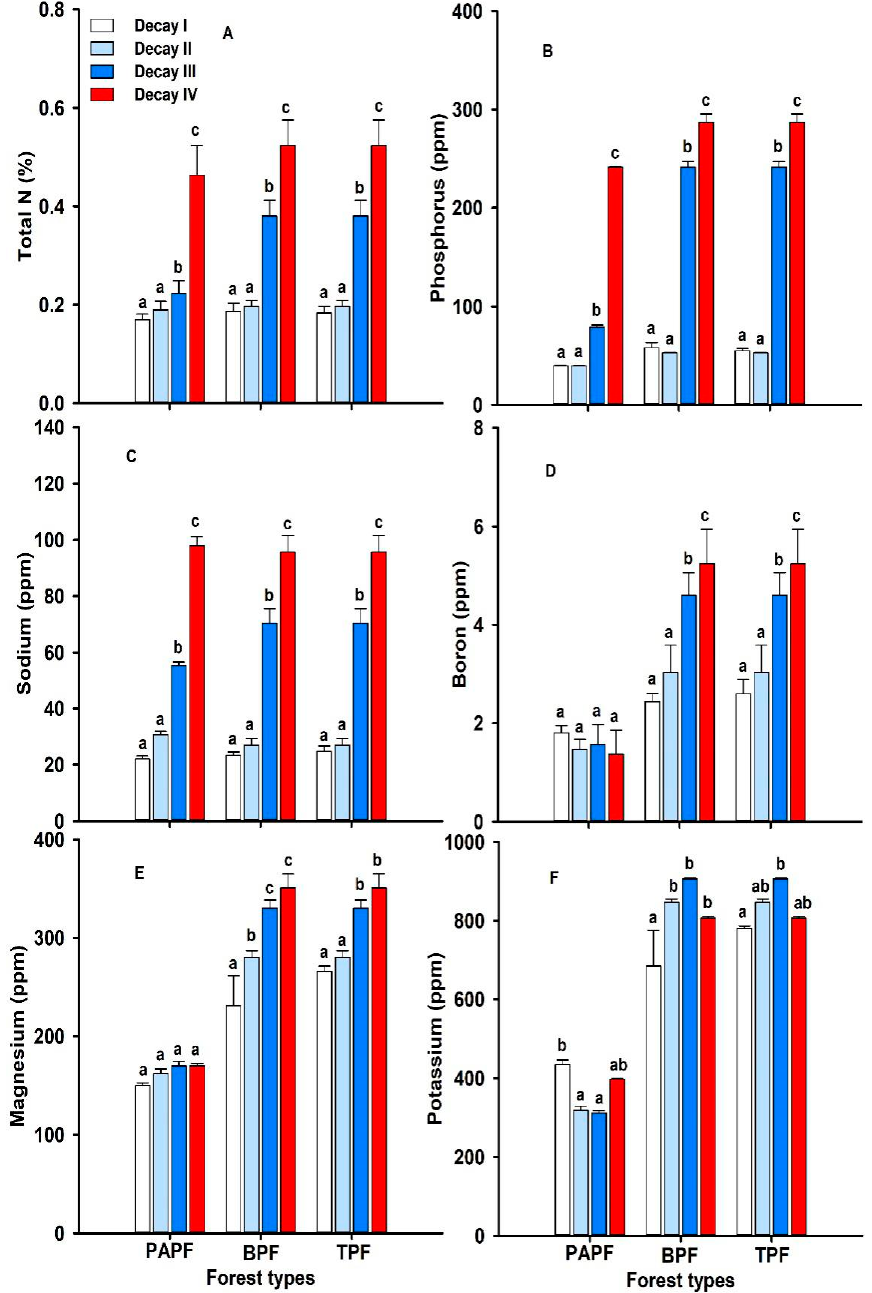
Figure 1. Total N (%) ( A ), phosphorus (ppm) ( B ), sodium (ppm) ( C ), boron (ppm) ( D ), magnesium (ppm) ( E ), and potassium (ppm) ( F ) concentrations of the same dominant tree species ( Pinus koreaensis , PK) with different decay classes in contrasting forest types of Picea koraiensis-Abies nephrolepis-Pinus koraiensis forest (PAPF), Betula costata-Pinus koraiensis forest (BPF), and Tilia amurensis-Pinus koraiensis forest (TPF) in northeastern China. Within the same forest type, significant differences between treatments are indicated by different lower-case letters. Values are means of three replicates, and the bars indicate standard error (Tukey’s honest significant difference (HSD) post hoc; p < 0.05, mean ± SE).